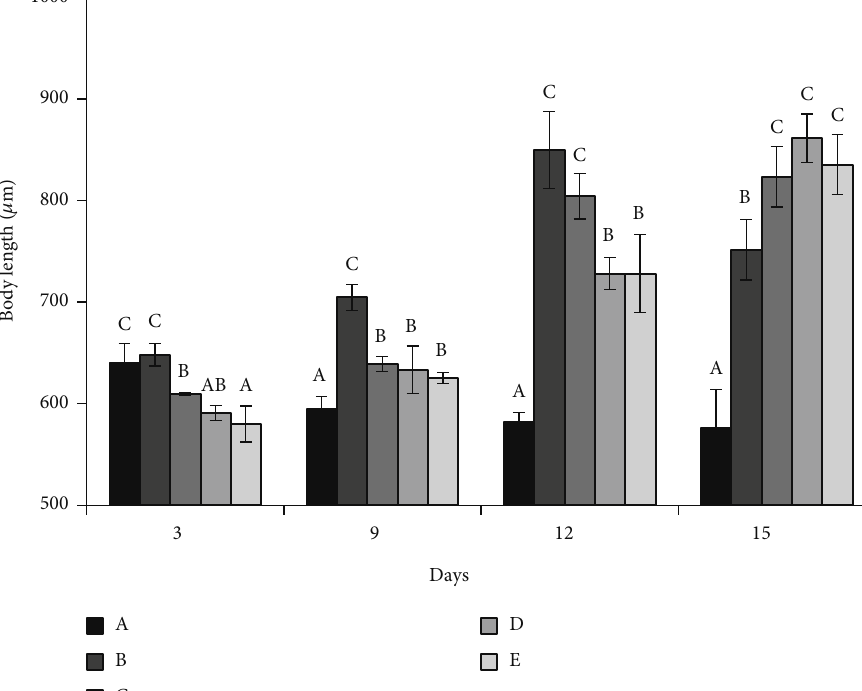
Figure 2: Variation in body length of Holothuria leucospilota larvae in di ff erent diet treatments. Data are presented as means ± SD ( n = 3 ). For a given sampling event, di ff erent letters above bars indicate signi fi cant di ff erences among